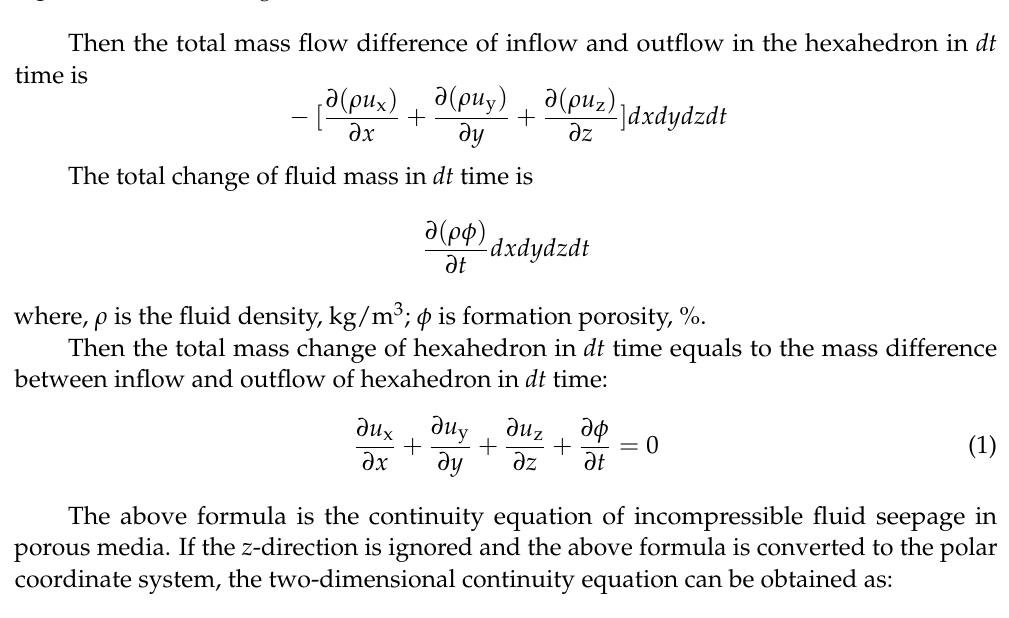
Figure 16. Schematic diagram of micro hexahedron unit.